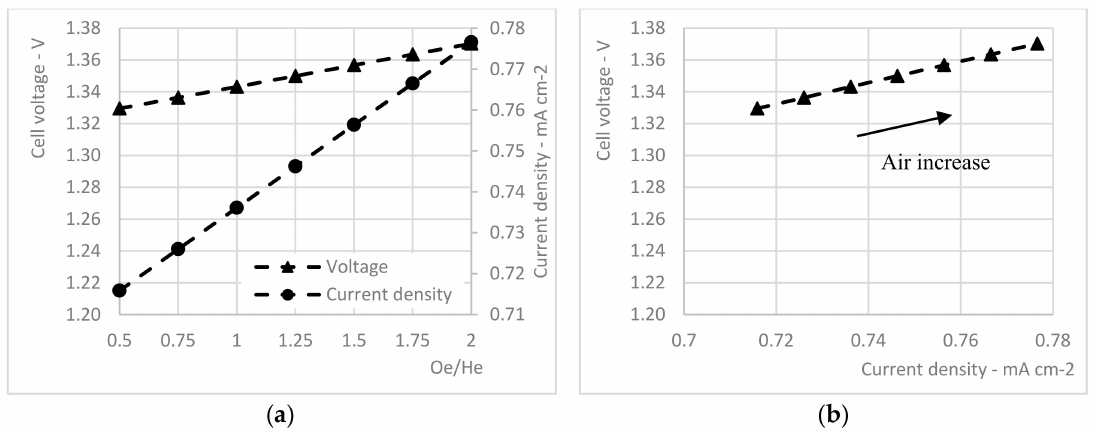
Figure 6. Cell voltage and current density plotted as function of Oe/He ( a ) and as function of each other ( b ).